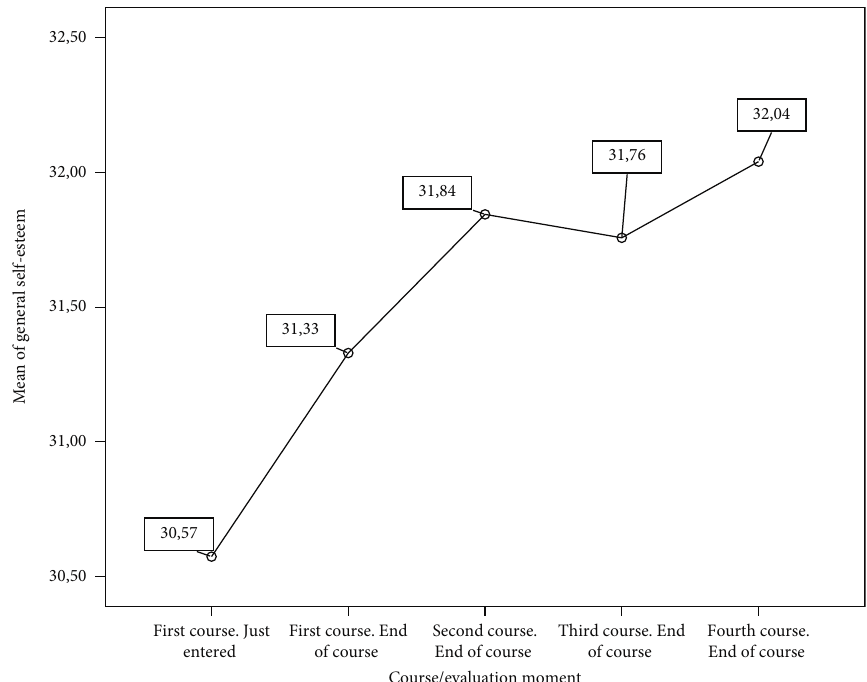
Figure 1: Developmental pattern of self-esteem in teaching students.